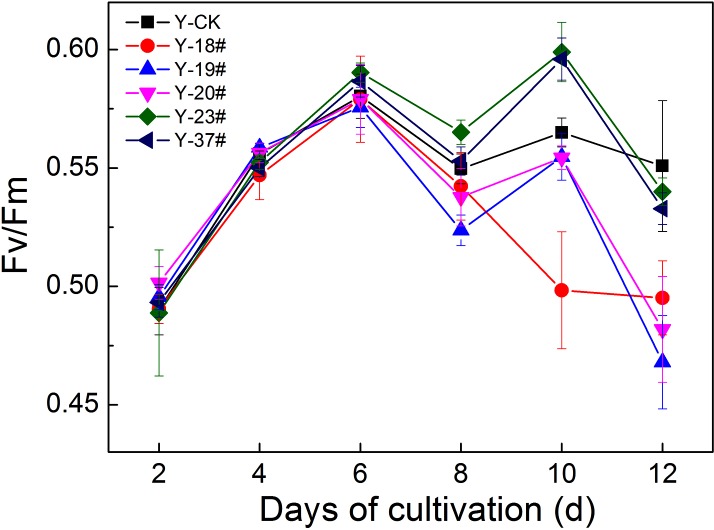
Fv/Fm of PSII of the progenies and of the control group.The Fv/Fm of the control group and of the progenies was determined at the indicated time points after dark adaptation for 8 min. Minimal fluorescence in the dark and maximal fluorescence upon a saturating light pulse were measured by Maxi-IMAGING-PAM at room temperature. The initial inoculation amount of each progeny and of the control group was 6.25% by volume; the Fv/Fm of the initial algal cell cultures (0 d) was too low to measure. n = 3+SD.